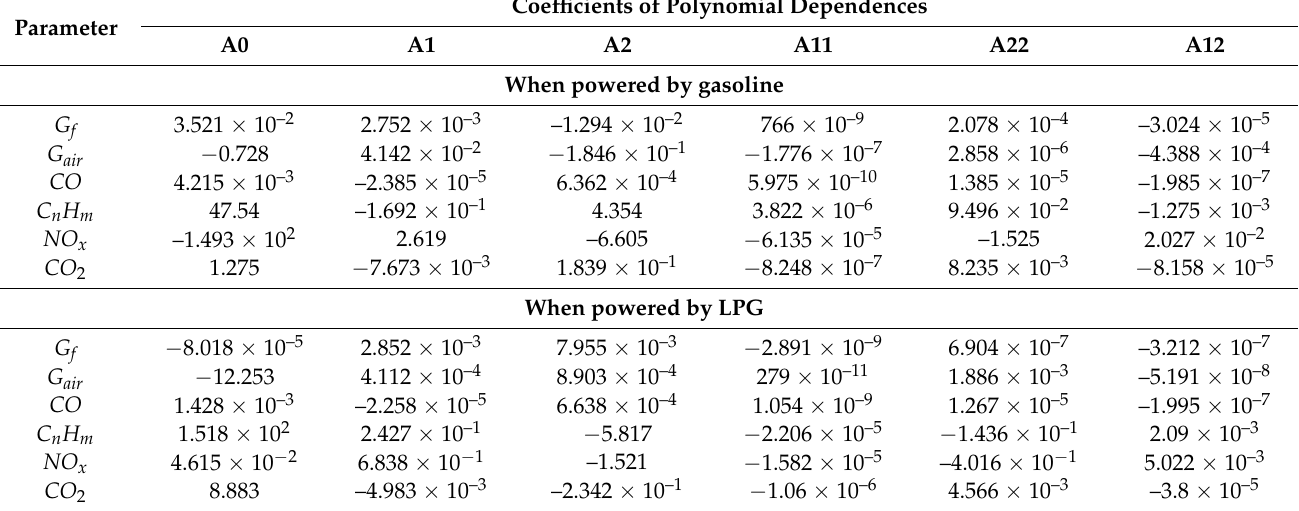
Table 1. Values of coefficients of polynomial dependences for loading modes of operation of the Daewoo Lanos engine.